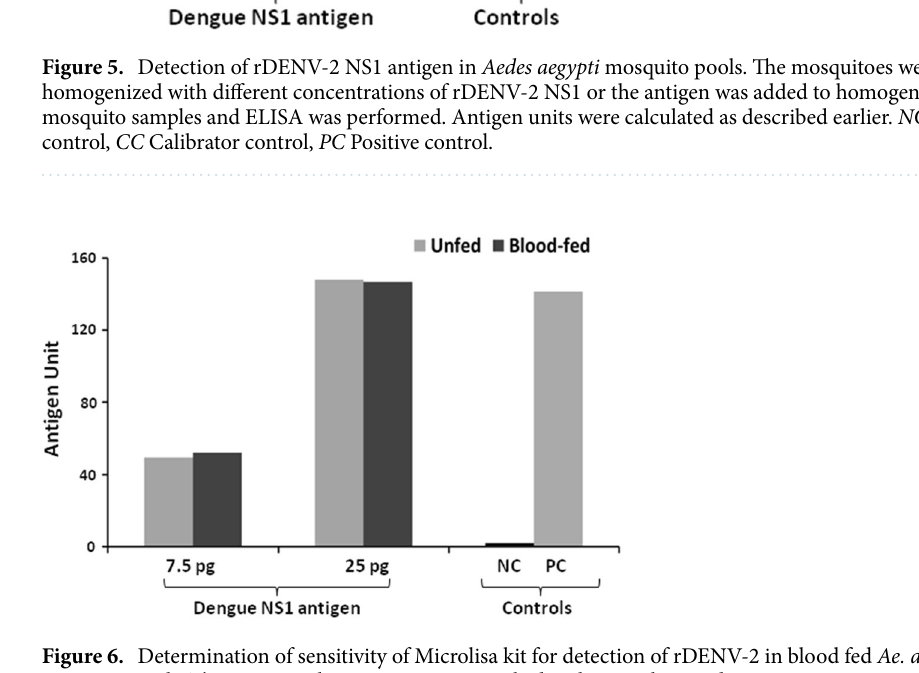
Figure 6. Determination of sensitivity of Microlisa kit for detection of rDENV-2 in blood fed Ae. aegypti mosquito pools. The mosquito homogenates were spiked with recombinant dengue NS1 antigen and tested. The absorbance was read in the ELISA reader at 450 nm. NC Negative control, PC Positive control.